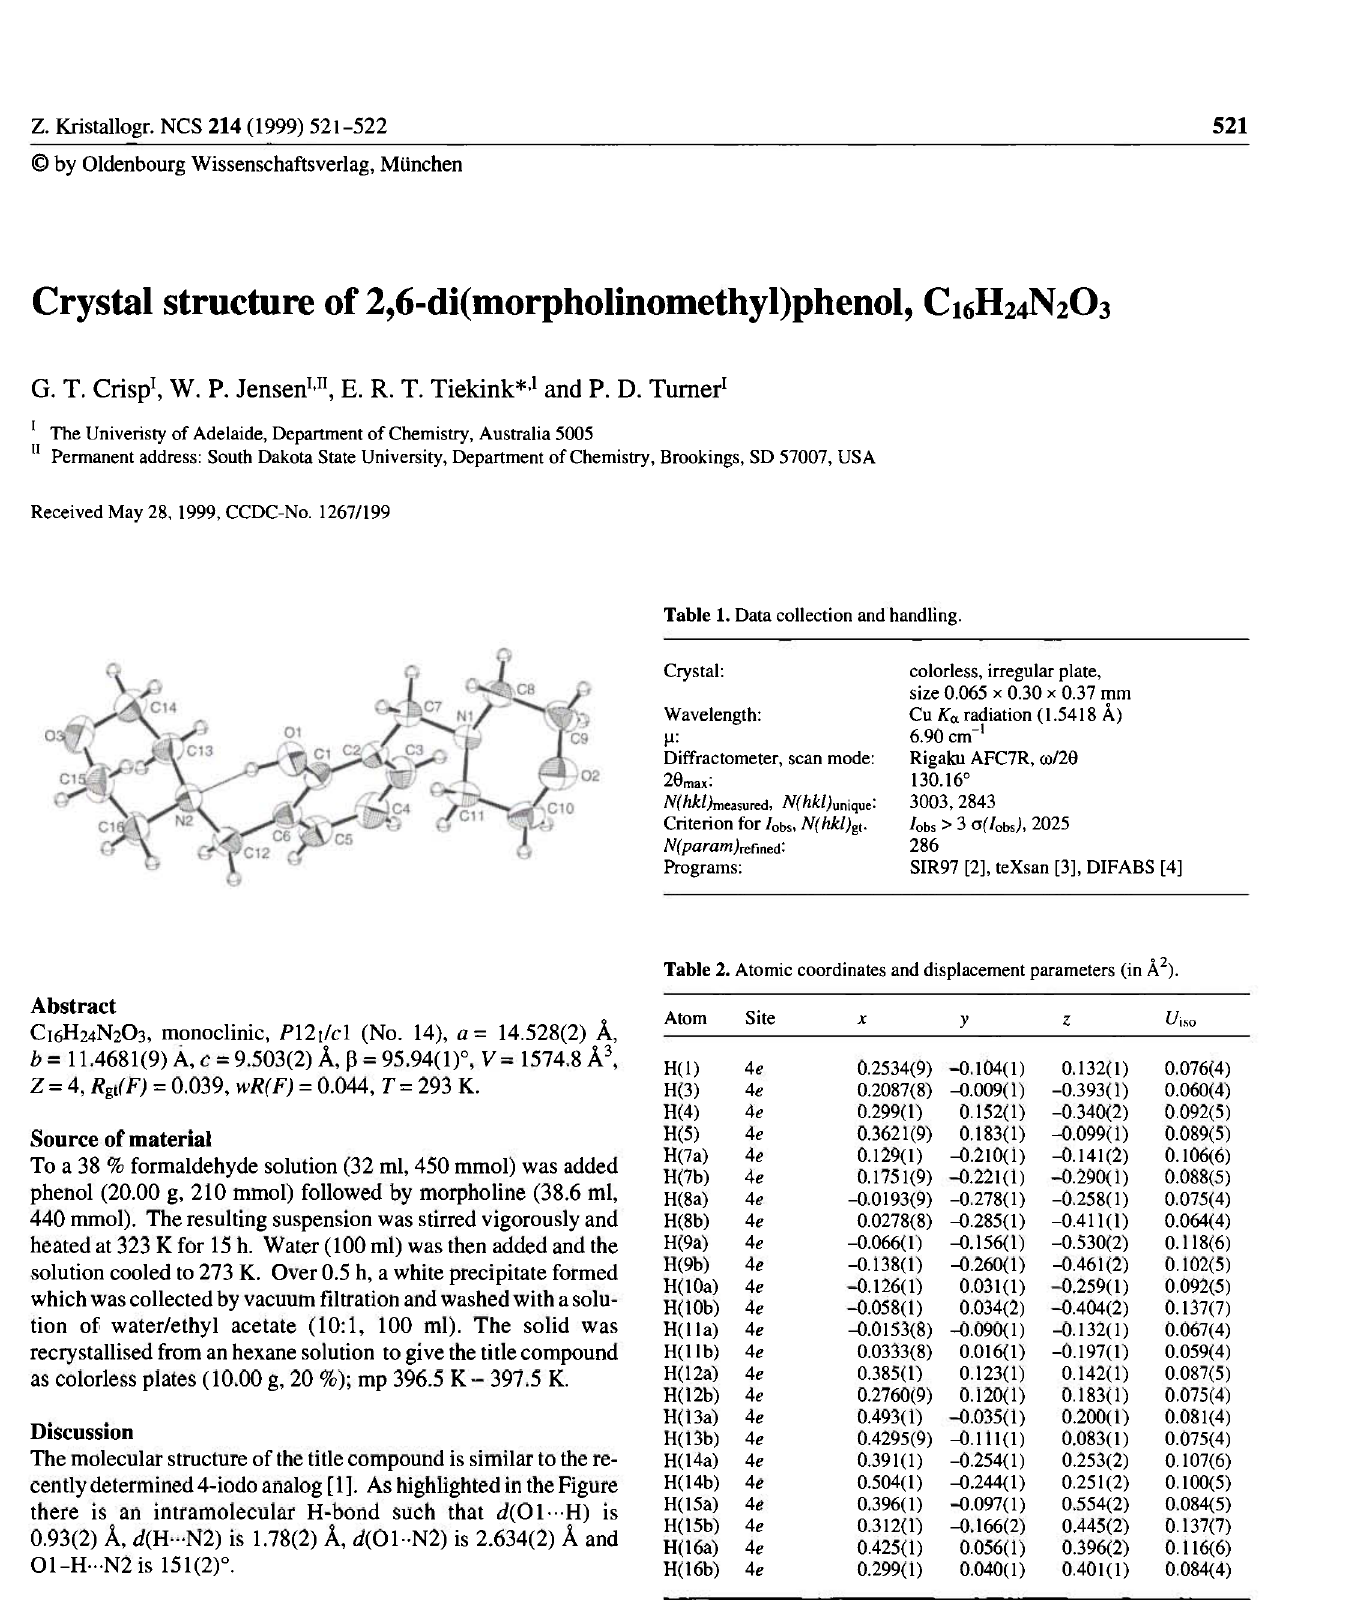
Table 2. Atomic coordinates and displacement parameters (in Ä 2